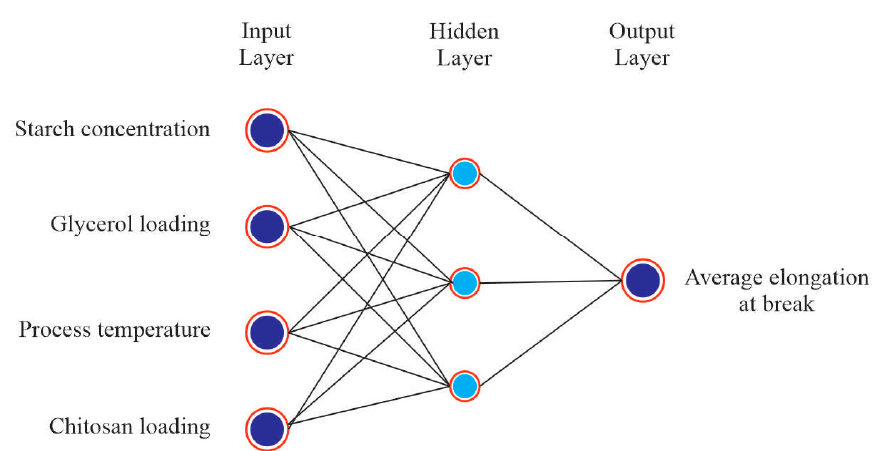
Figure 7. Architecture of ANN model for elongation at break. Table 2. Comparison of the experimental tensile strength and predicted tensile strength by ANN